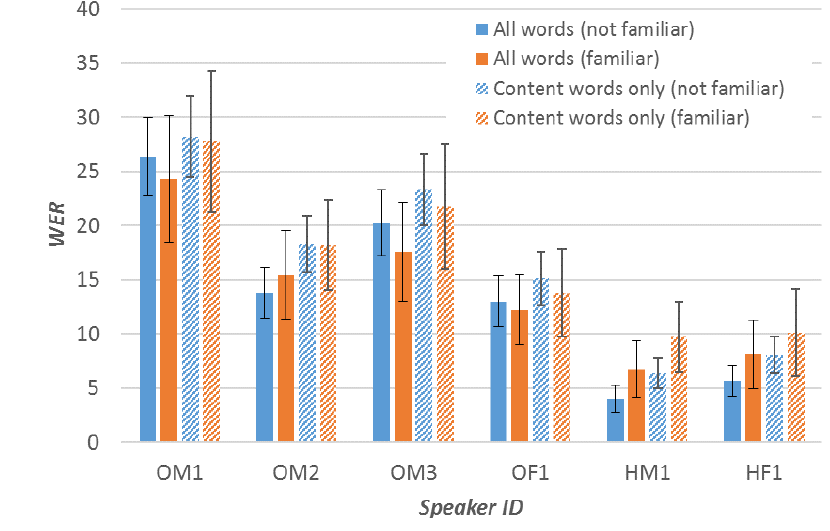
Figure 1. Mean speakerwise ‘All words’ and ‘content words only’ Word Error Rates (WER) for ‘familiar’ and ‘not familiar’ listeners. OM1, OM2, OM3, OF1 are oesophageal speakers; HM1 and HF1 are healthy speakers. Higher WER corresponds to lower intelligibility. Error bars show 95% confidence